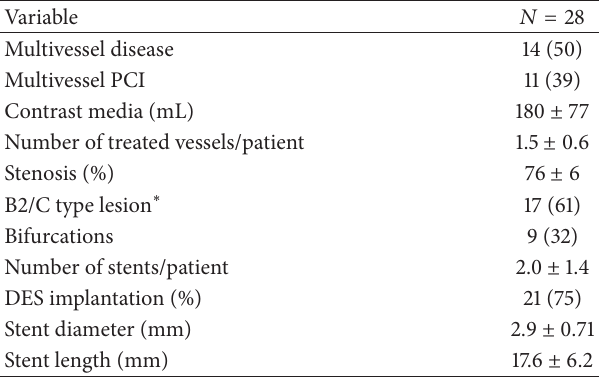
Table 3: Angiographic and procedural